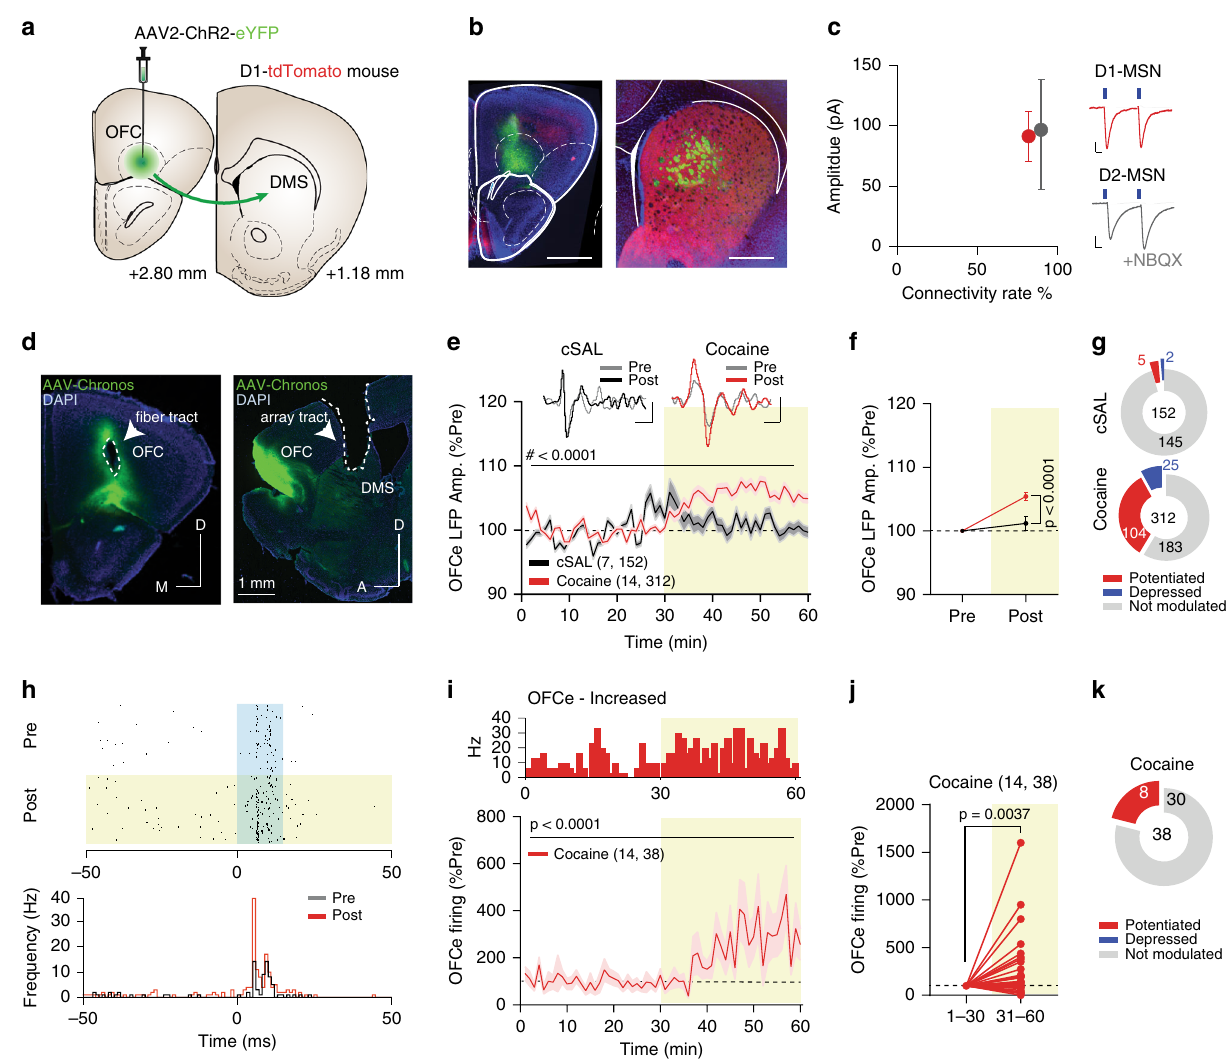
Fig. 3 Cocaine increases OFC-DMS pathway ef fi cacy. a Schematic of ex vivo recordings. ChR2-eYFP was targeted to the OFC and slice recordings were performed in the DMS of D1-tmt mice. b Example histology showing fl uorescence in OFC and fi bers in DMS. Scale bar: 1 mm. c Connectivity rates between OFC and dMSNs or putative iMSNs. Right: example currents evoked by 4 ms illumination with blue light. Scale bar: 10 ms, 20 pA. d Representative images of Chronos expression in OFC with fi bers projecting to DMS. e Time-course of normalized OFCe LFP amplitude for cocaine and saline (cSAL) (two-way ANOVA; time main effect: F (59,27720) = 13.18, p < 0.0001; drug main effect: F (1,27720) = 225.7, p < 0.0001; time Χ drug interaction: F (59, 27720) = 10.27, p < 0.0001). Scale bar: 20 ms, 2 μ V. f Binned OFCe LFP amplitude (two-way ANOVA; time main effect: F (1,924) = 35.11, p < 0.0001; drug main effect: F (1,924) = 14.27, p = 0.0002, time Χ drug interaction: F (1,924) = 14.27, p = 0.0002; followed by between-subject Bonferroni post hoc test; Pre: cSAL vs cocaine: t (924) = 0, p > 0.9999; post: t = 5.342). g Pie-charts reporting the number of signi fi cantly potentiated, depressed or non-signi fi cantly modulated OFCe LFP (924) responses. h Representative raster-plot and peri-stimulation histogram of OFCe responses. i Time-course of normalized OFC-stimulation evoked fi ring rate (RM one-way ANOVA, F (59,2183) = 3.056). j Binned OFCe fi ring frequency in response to cocaine (two-tailed Wilcoxon matched pairs signed rank test: W = 392.0). k Pie-charts reporting the number of OFCe fi ring responses. Data are represented as single points and/or as mean ± SEM. N , n indicate number of mice and OFCe LFPs or units included in the analysis. (Fig. 3d) and measured light-evoked changes in striatal local fi eld potentials (LFPs), a measure of cortical-input ef fi cacy 46,47 before (Pre) and after (Post) mice received an i.p. injection of cocaine or saline (Cocaine, n = 14 mice, and cSAL, n = 7 mice, Fig. 3d). We included wires with evoked LFP responses for further analysis (see Methods). This included 312 wires for cocaine, and 152 wires for saline. As we hypothesized, cocaine increased the amplitude of OFC-evoked (OFCe) striatal LFP responses (Fig. 3e – g). This effect was also observed at a per-mouse level, when OFCe LFP responses from each mouse were averaged (Supplementary Fig. 3a). Next, to investigate whether changes in evoked LFPs